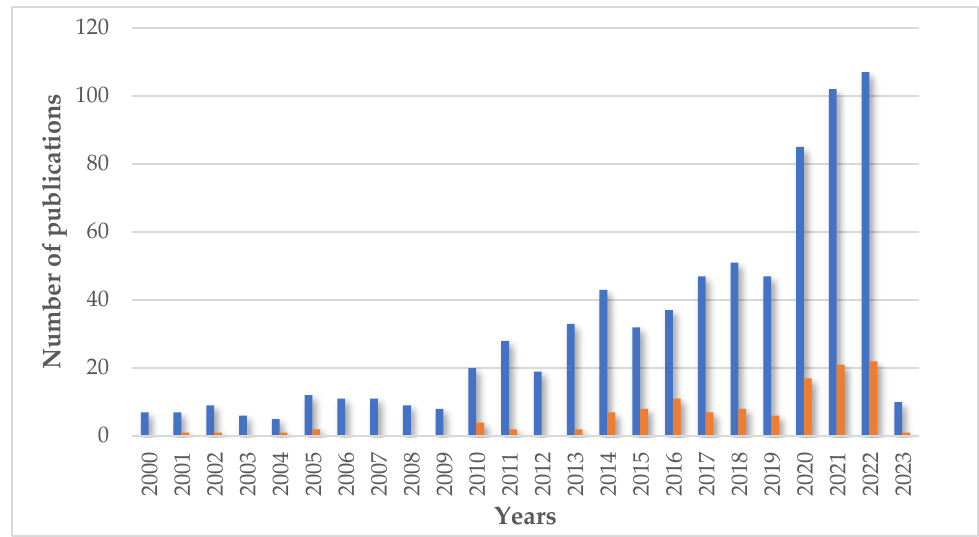
Figure 10 . The number of publications in the years about chitosan in cosmetics (▪ search for words “chitosan” and “cosmetics”) and final products based on chitosan ( ▪ search for term “cosmetic based on chitosan”). Figure is based on data from Scopus database (in both cases, including title, abstract, and keywords; [https://www.scopus.com/search/form.uri?display=basic#basic; accessed on February 2023]).